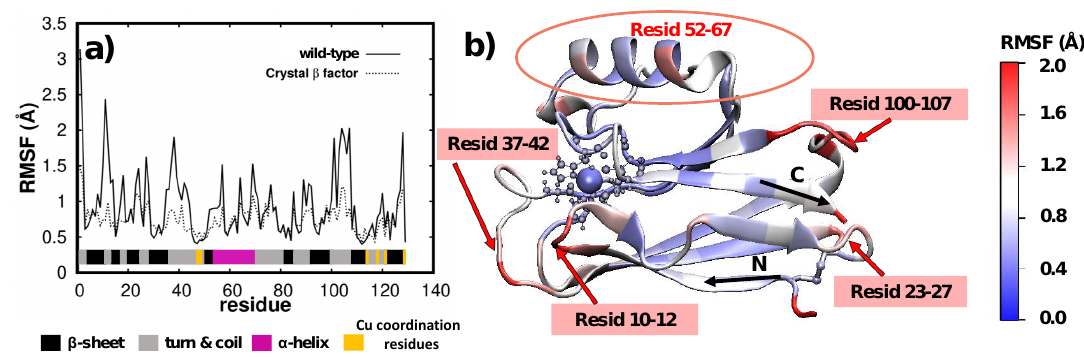
Figure 3. Fluctuations (RMSF) per amino-acid of an unrestrained wild-type protein in water. ( a ) RMSF of each wild-type residue over the last 200 ns of MD simulation. The same values obtained from the crystallographic β -factors [34] are also included with a dashed line.Secondary structure of each amino-acid is also detailed. ( b ) RMSF data for each residue/amino-acid represented directly over the wild-type protein averaged structure. The Azurin representation used is the same as in Figure